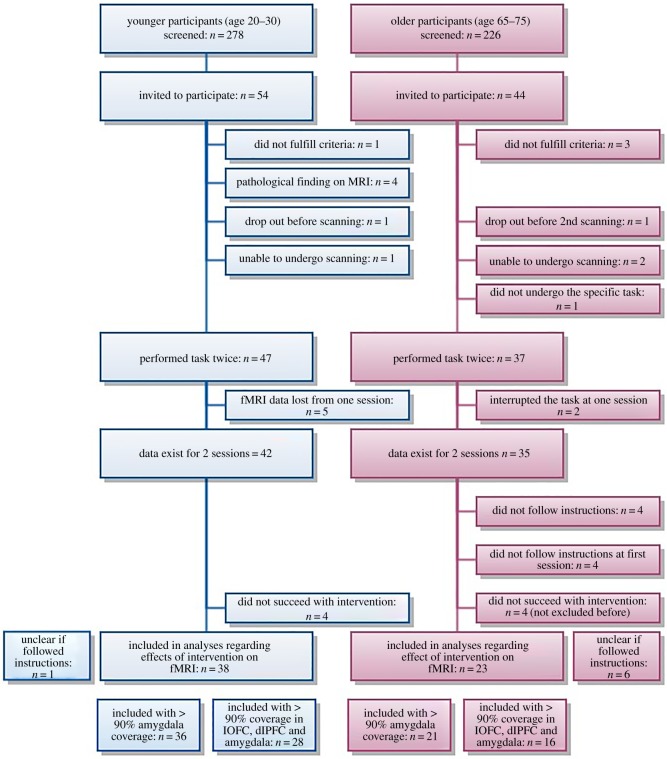
Inclusion flowchart.